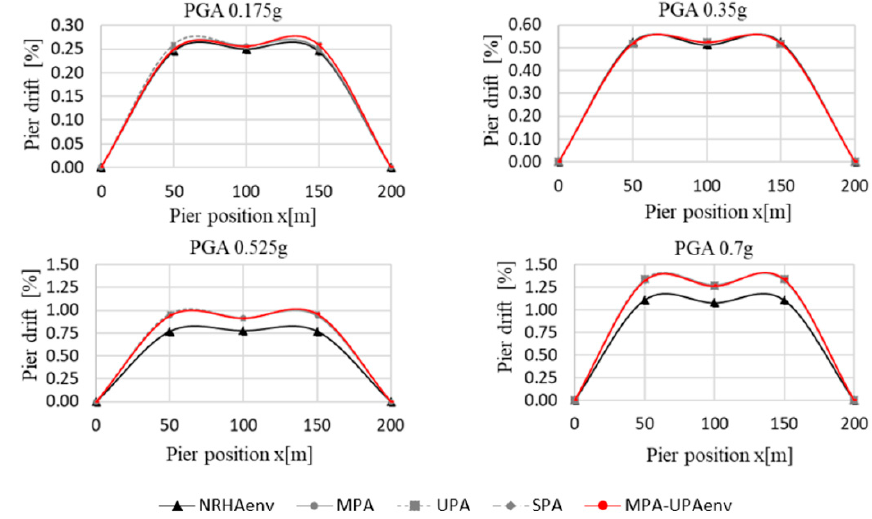
Figure 16. Regular bridge—pier drift (transversal top displacement / height) derived by performing nonlinear dynamic analysis and pushover analysis according to the approaches considered (PGA from 0.175 to 0.7 g).